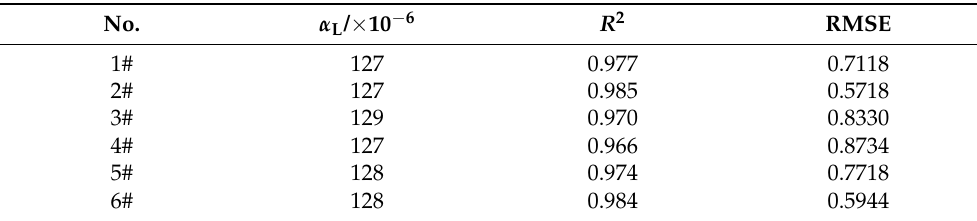
Table 2. Data from the six samples shown in Figure 8 were taken to exponentially fit the relationship between c L and T .